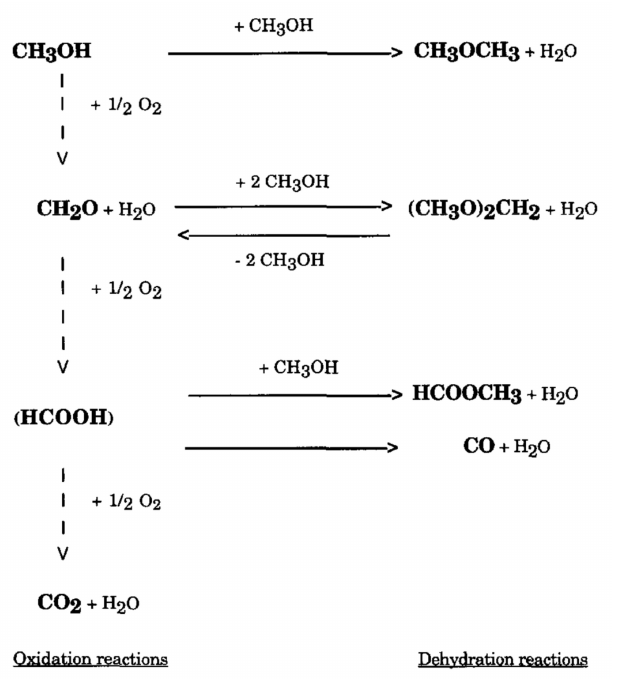
Figure 5. Scheme showing the reaction pathways for MeOH conversion via either oxidation or dehydration reactions. Reprinted from [45] Copyright © 1997 with permission from